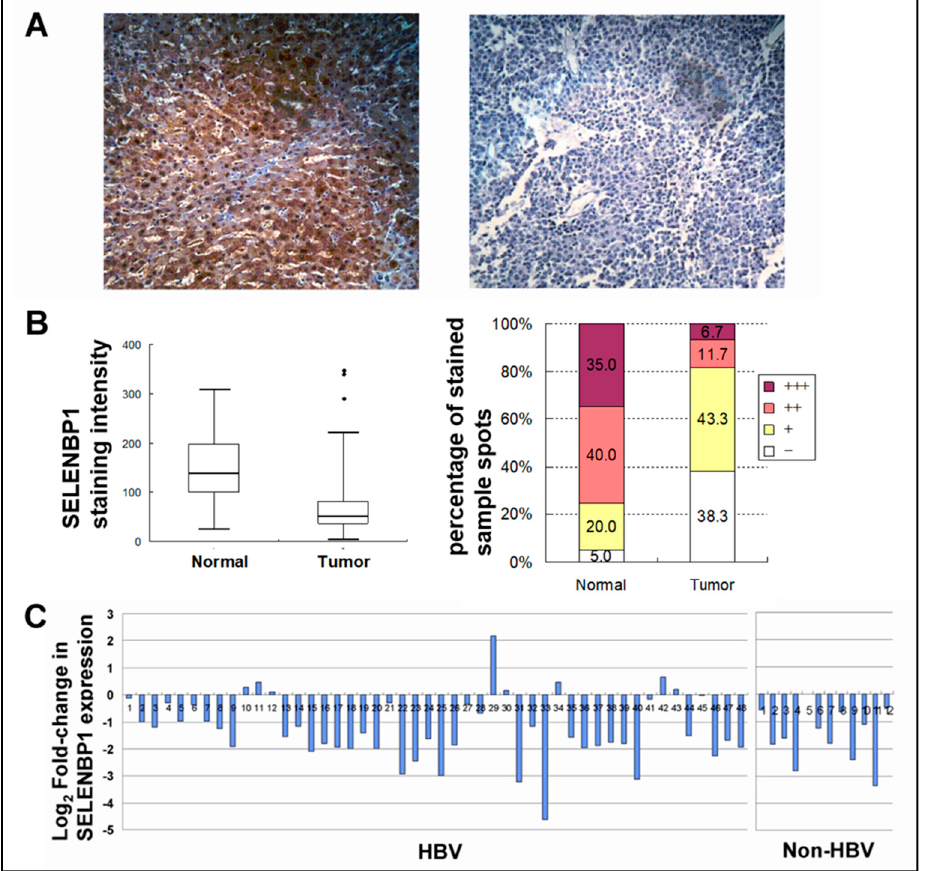
As compared with matched non-tumor (counterpart normal) liver tissues, levels of SELENBP1 were decreased in 43 HCC cases (71.7%) and were elevated in three cases (3.3%) more than 1.5-fold. In the other 15 (25%) couples of HCC and matched non-tumor (counterpart normal) liver tissues, no obvious di ff erence of SELENBP1 expression was detected. Other clinicopathological factors, such as information on the diagnosis of hepatitis B virus infection, gender, and tumor grades, had no relevance with SELENBP1 expression (Table S2).